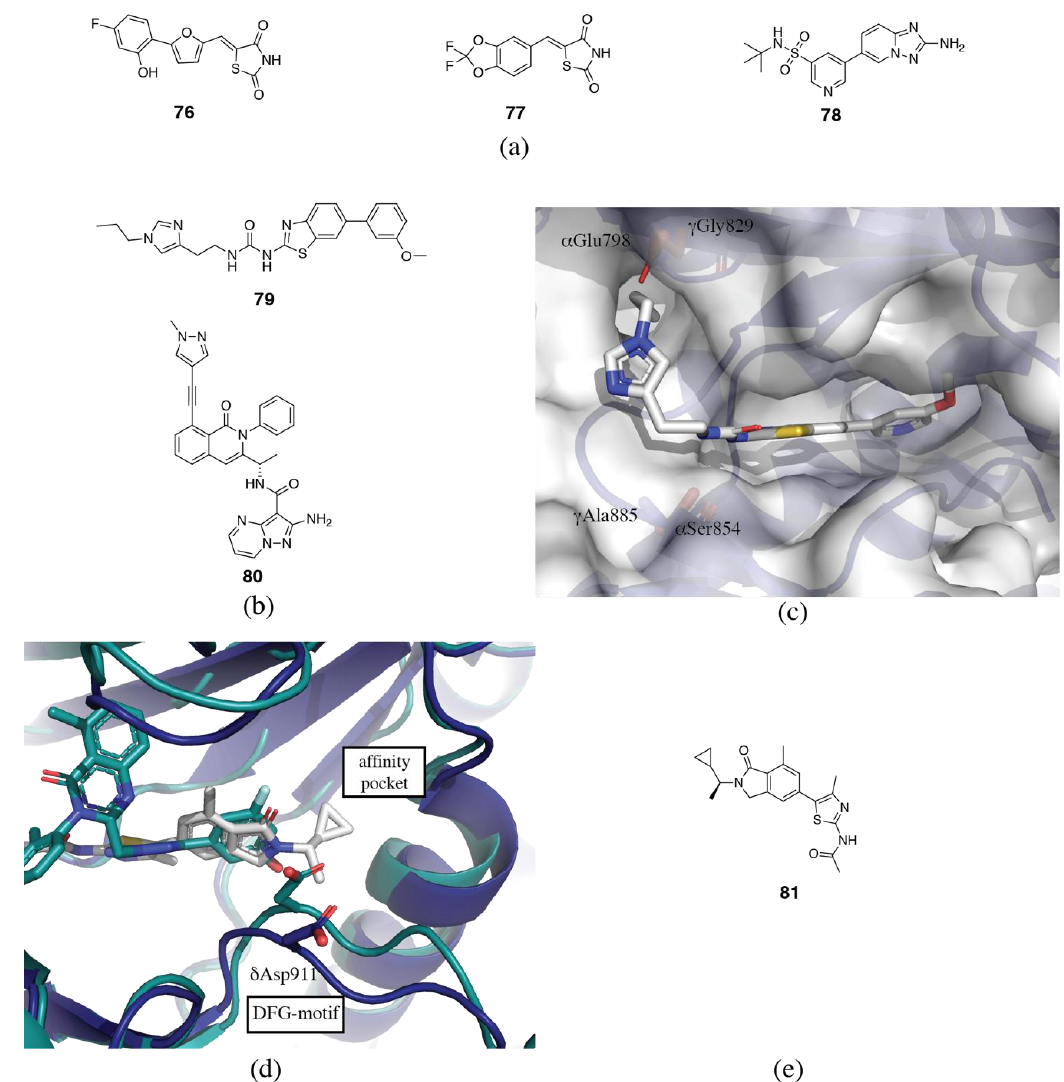
Figure 12. PI3K γ selective inhibitors. ( a ) Structures of 76 – 78 . ( b ) Structures of 79 – 80 . ( c ) The hydrophobic binding cleft in p110 γ (PDB ID 4PS3). The structure of p110 γ bound to 79 is shown in dark blue cartoon and light gray surface representation. An overlay with p110 α (raspberry, PDB ID 4JPS) highlights how α Glu798 obscures the binding cleft. The cartoon of p110 α has been hidden for clarity. ( d ) The “alkyl-push”. The structure of 81 bound to p110 δ (dark blue, PDB ID 6FTN). The cyclopropyl tail of 81 (shown in white) extends deeper into the affinity pocket than previously observed. The structure of 1 bound to p110 δ (teal, PDB ID 2WXG) has been shown as a comparison for typical affinity pocket binding moieties. A shift in the loop containing the DFG-motif and helix at the back of the affinity pocket can be observed. ( e ) Structure of 81 .